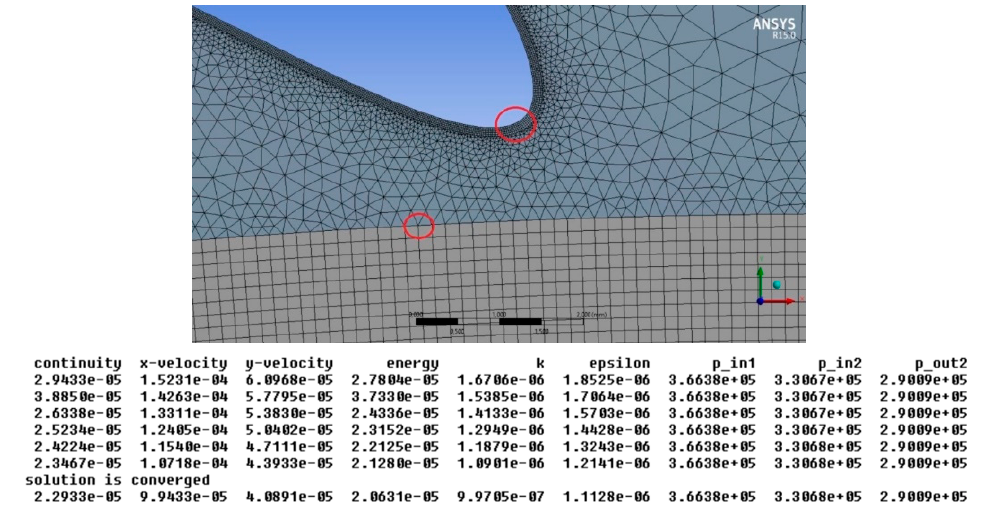
Figure 14. Mesh quality after refinement.